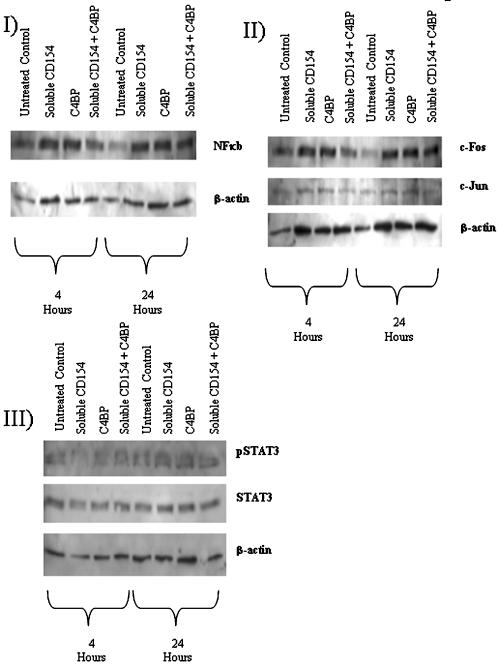
Representative Western blots showing NFkB, c-Fos and c-Jun and pSTAT 3 levels in response to CD154/C4BP stimulation. Aliquots of nuclear or cytoplasmic extracts as appropriate (40 ug protein) from cultured and stimulated primary human cholangiocytes were probed for NFkB (panel I); c-Fos and c-Jun(panel II) or pSTAT3 content. Blots were stripped and re-probed for beta-actin which allowed for normalisation of data for variations in protein loading.